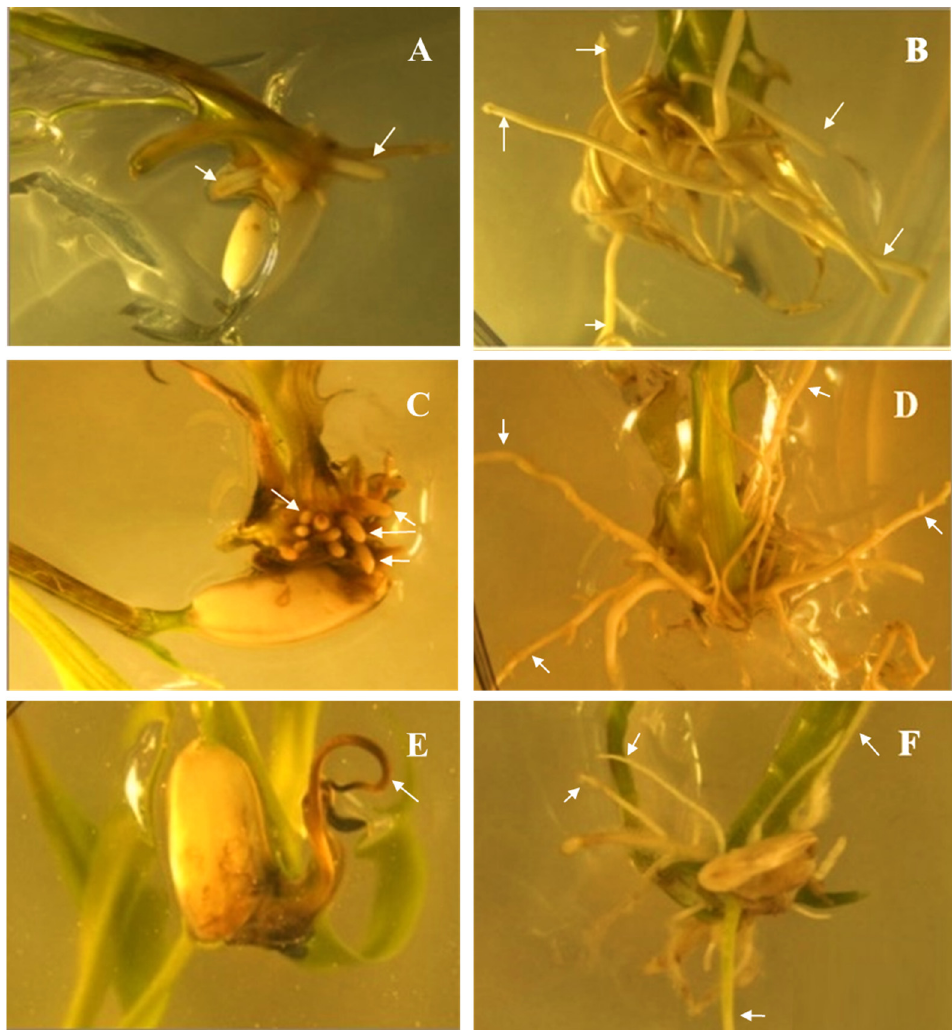
Figure 5. Agar-based assay showing root growth of rice seedlings in different concentrations of fomesafen. Root growth of wild type at 5 µM ( A ), 40 µM ( C ), and 100 µM ( E ), root growth of T 2 plants at 5 µM ( B ), 40 µM ( D ), and 100 µM ( F ). White arrows show inhibited root growth in ( A , C , E ); and healthy root growth in ( B , D , F ).